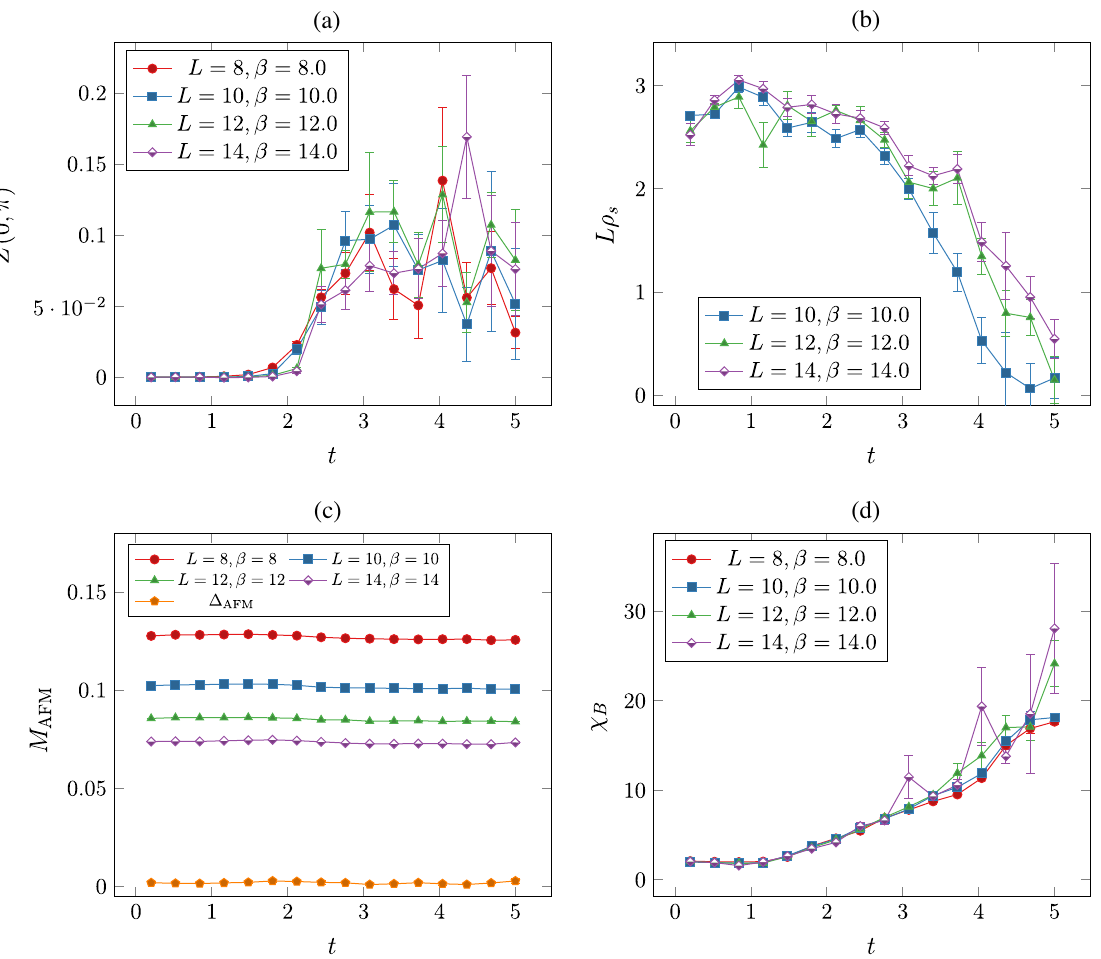
˜ Z ð k Þ at . Δ is computed AFM AFM